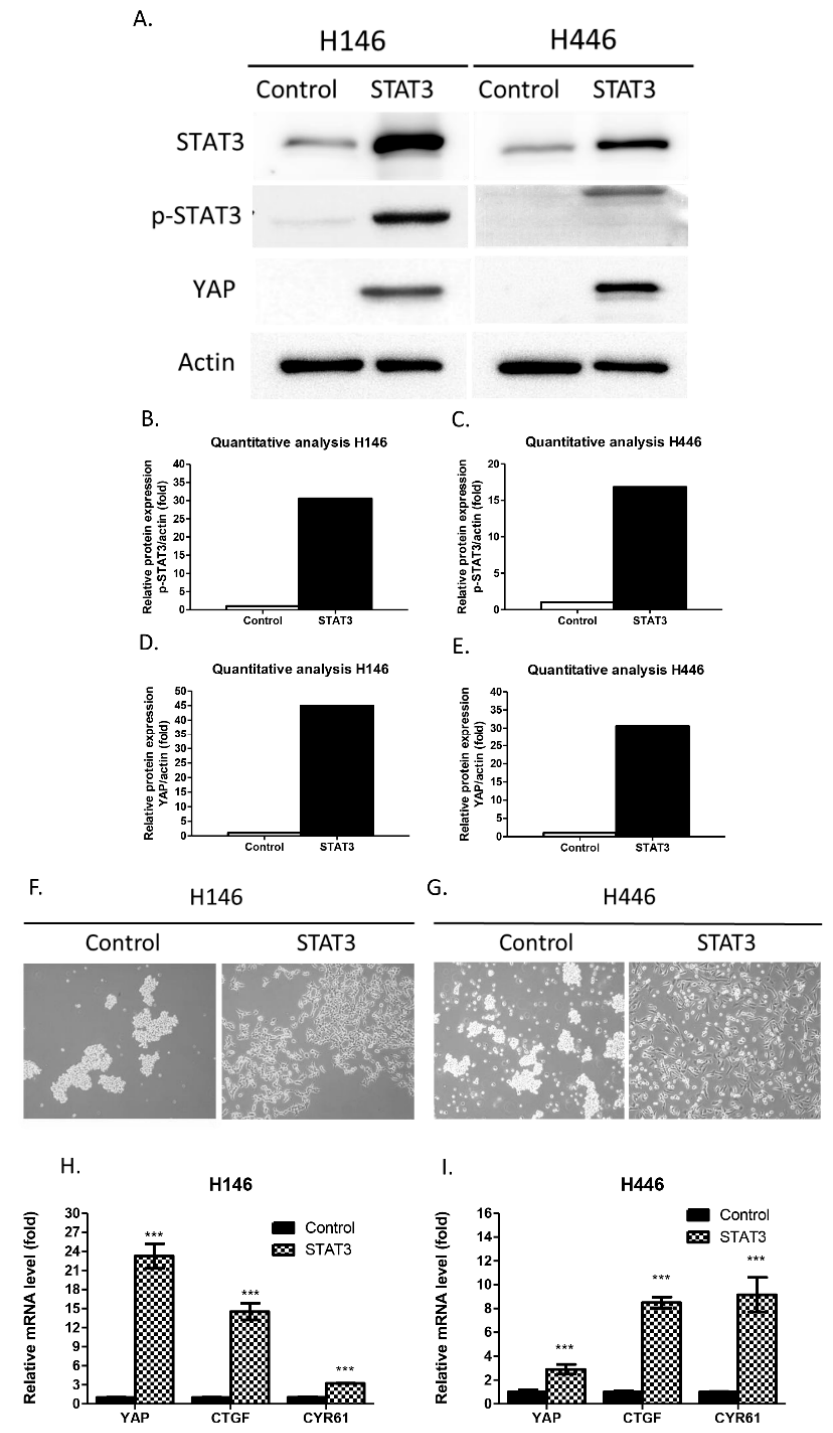
Figure 2. Forced overexpression of STAT3 increased YAP protein, YAP mRNA and YAP signaling downstream CTGF and CYR61 mRNA expression in H146 and H446 cells. ( A – E ) The STAT3, p-STAT3 and YAP protein expression levels increased in STAT3-overexpressing H146 and H446 cells compared with control H146 and H446 cells. ( F , G ) The floating cell morphology was changed to an adherent cell morphology after STAT3 overexpression in H146 and H446 cells. ( H , I ) YAP, CTGF and CYR61 mRNA expression significantly increased in STAT3-overexpressing H146 and H446 cells compared with control H146 and H446 cells. (Error bars indicate standard deviations; *** p ≤ 0.001.)